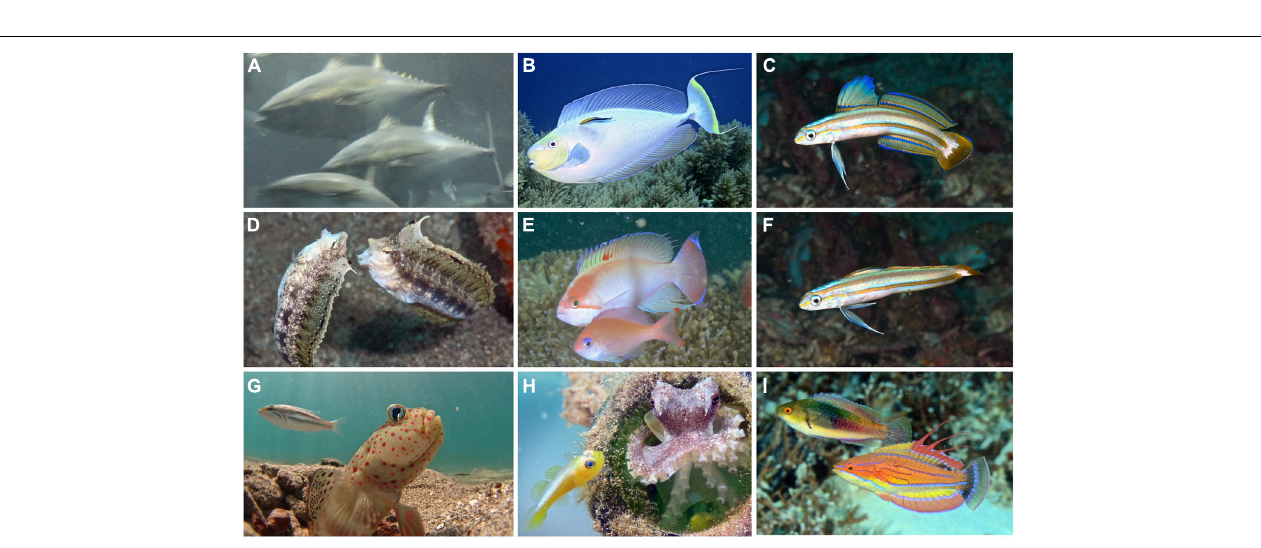
FIGURE 10 | Photographs of the dorsal fin (DF) positions of Pacific bluefin tuna, Thunnus orientalis , showing the DF unfolded (2 top fish) for hydrodynamics while turning, and folded in the lower fish (A) , a bignose unicornfish, Naso vlamingii , unfolding its DF while be cleaned by a cleaner fish (B) , a lined dartgoby, Ptereleotris grammica , unfolding its DF when frightened or threatened probably because of the camera flash (C) and then with its DF completely folded (F) , the unfolded DF of 2 fighting sabretooth blenny, Petroscirtes xestus (D) , a male pink basslet, Pseudanthias hypselosoma , unfolding its DF during courtship with a female (E) , a pink-speckled shrimp goby, Cryptocentrus leptocephalus , with an unfold DF while wary of a three-striped whiptail, Pentaposus caines , whose DF is folded (G) , an unfolded DF in a goby, Lubricogobius sp., whose own burrow has been occupied by a coconut octopus, Amphioctopus marginatus (H) , and two different species of wrasses (blueside wrasse, Cirrhilabrus cyanopleura , upper; pink flasher, Paracheilinus carpentri , lower) that both have their DF unfolded while threatening each other (I) .